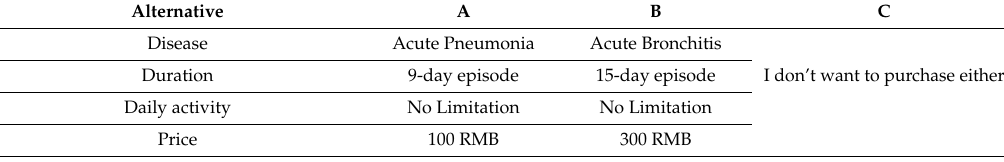
Table A5. Choice set 5.